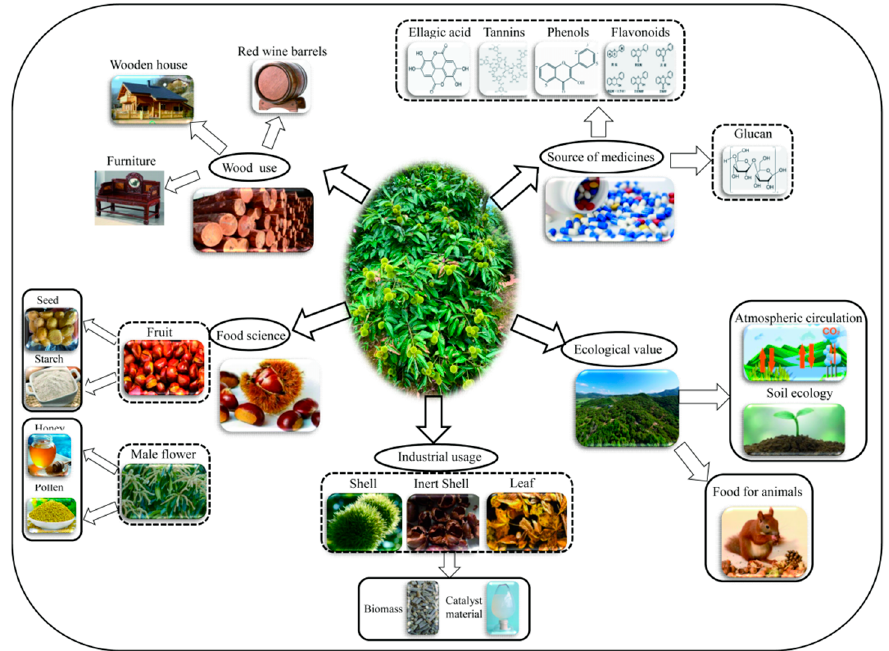
Figure 1. Flowchart of the processing and utilization of the wood, leaves, and nuts of chestnut trees. Castanea mollissima Bl. is a multi-value species with high ecological value that is widely used in the food, nutraceutical, pharmaceutical, and industrial raw material industries.